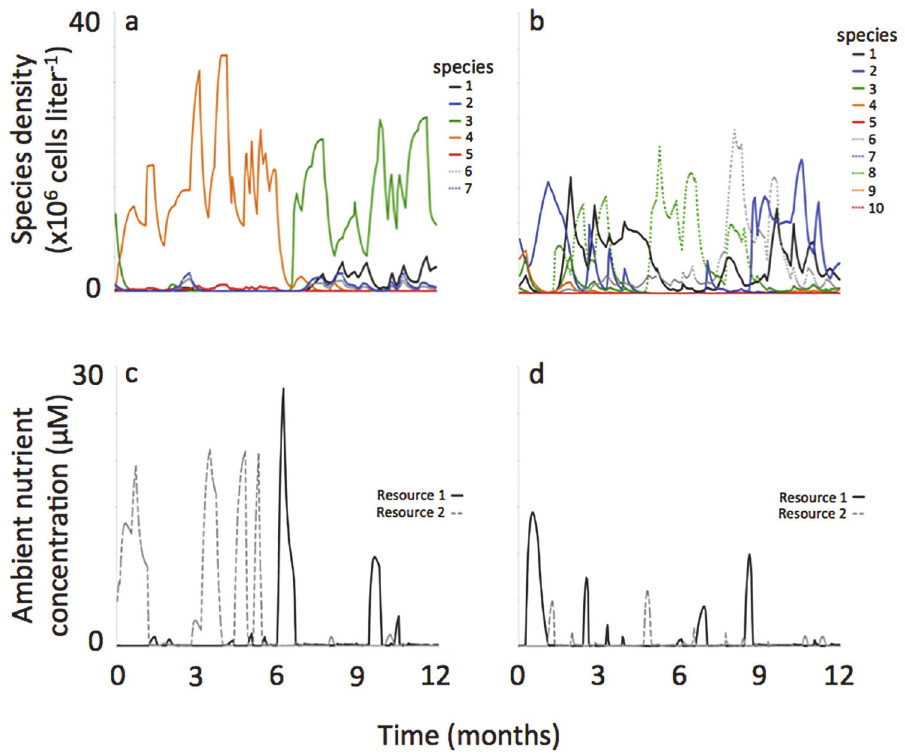
Fig 7. Representative phytoplankton population dynamics and ambient resource concentrations when reversals in the resource supply concentrations were sudden (a, c) and gradual (b, d). In these simulations there was 0 – 80% noise applied to the resource supply. Values of k S and Q S for phytoplankton populations are provided in Table